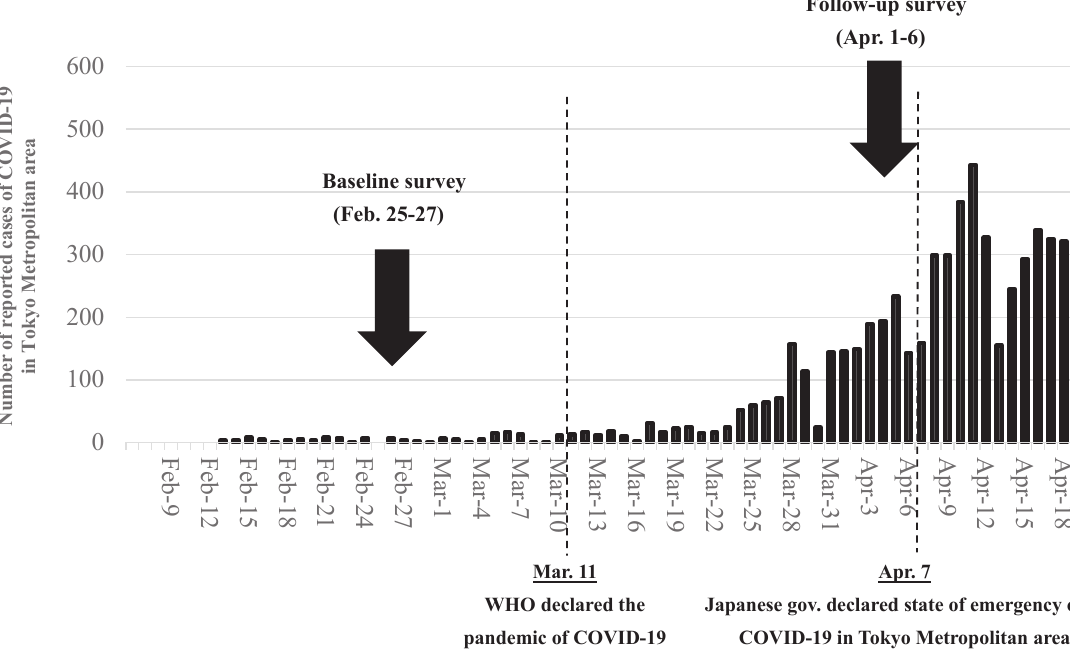
Figure 1. Date of surveys with COVID-19 epidemic curve in Tokyo Metropolitan